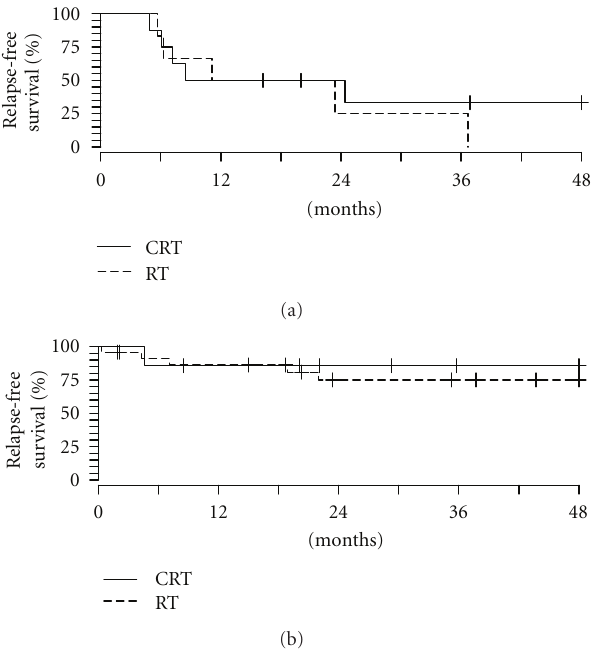
Figure 4: Estimated relapse-free survival in patients with bone invasion (a) and without bone invasion (b) treated with chemora- diotherapy (CRT) and radiotherapy